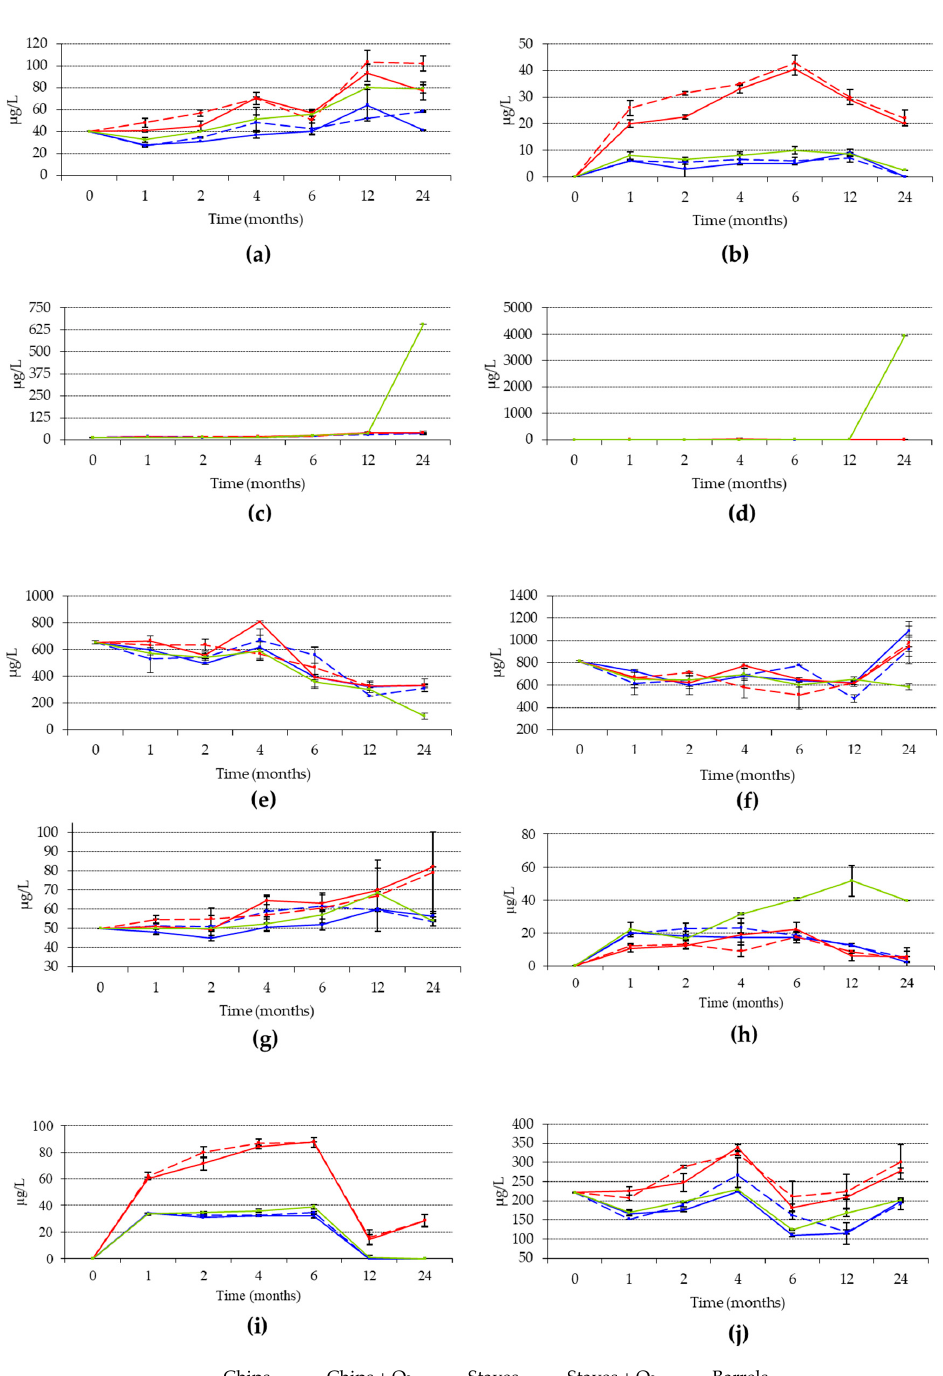
Figure 4. Evolution of volatile phenols concentration ( µ g/L) over time: ( a ) guaiacol; ( b ) 4-methylguaiacol; ( c ) 4-ethylguaiacol; ( d ) 4-ethylphenol; ( e ) 4-vinylguaiacol; ( f ) 4-vinylphenol; ( g ) phenol; ( h ) eugenol; ( i ) trans -isoeugenol; and ( j ) syringol. Mean ± standard deviation ( n = 2).